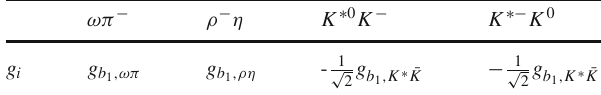
Table 5 Couplings of the I = 1, G = + 1, axial-vector resonance b 1 ( 1235 ) to the different V P channels